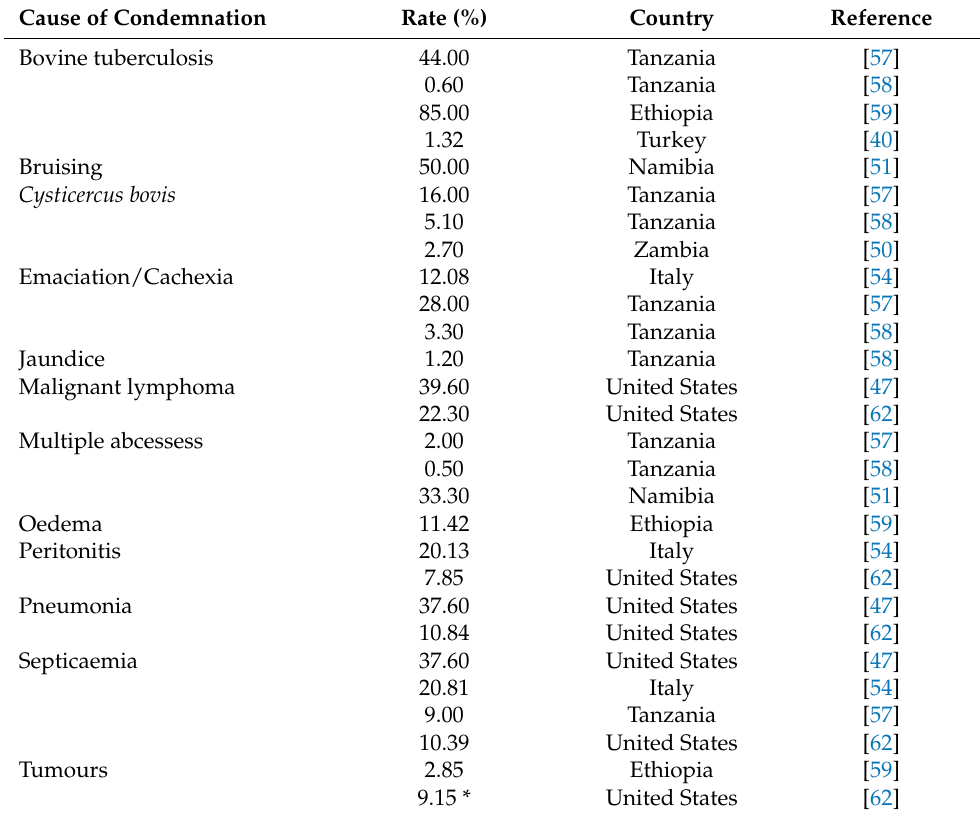
Table 2. Main causes of carcass condemnation in